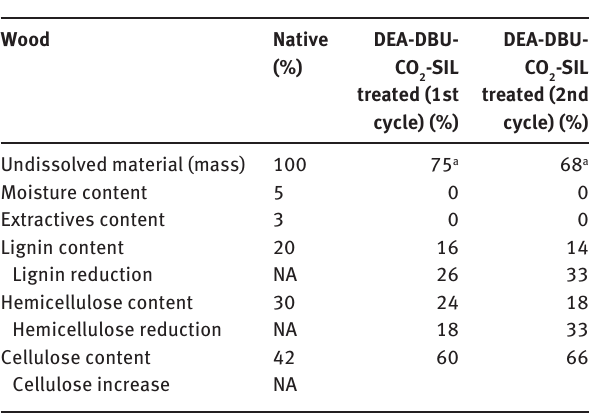
Table 1 Summary of the chemical analysis of the treated and untreated wood.